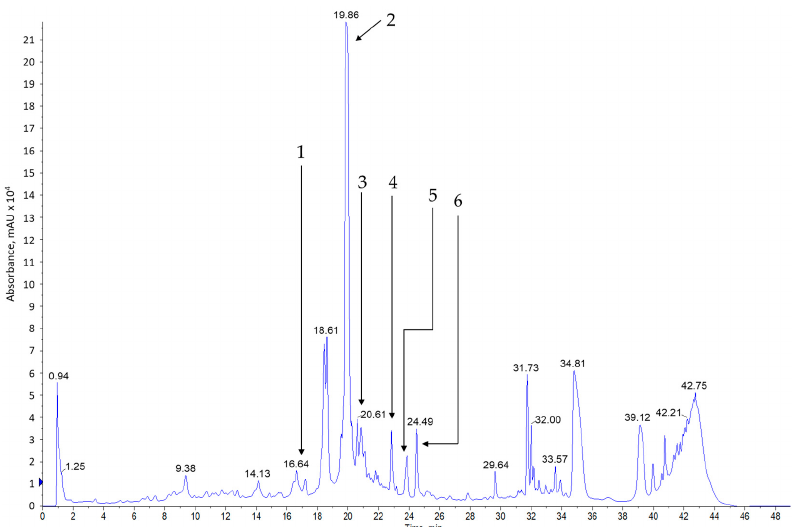
Figure 2. Example of DAD chromatogram for extract of salvia leaves in June dried naturally of the